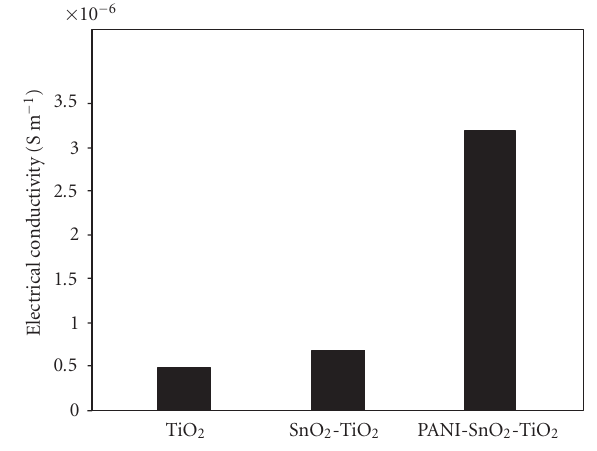
Figure 4: Electrical conductivity of